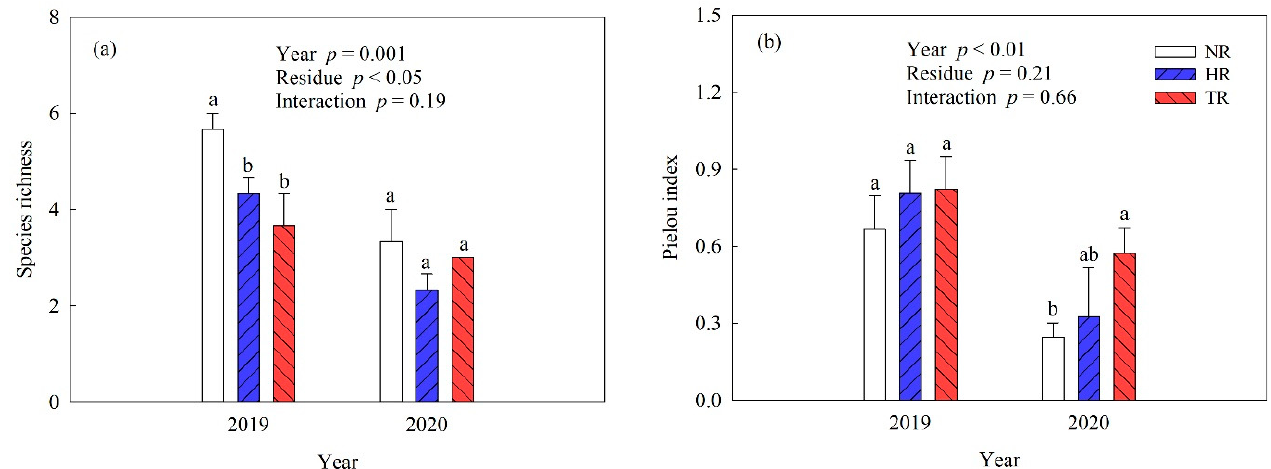
Figure 3. Community-level diversity (( a )—species richness, ( b )—Pielou evenness index) under treatments (NR, no crop residues retention; HR, half crop residues retention; TR, total crop residues retention) during the observation period. Different letters indicate significant differences at the 0.05 level between the treatments. Bars represent means ± SE. Statistical results above the bars show the linear mixed-effects model.